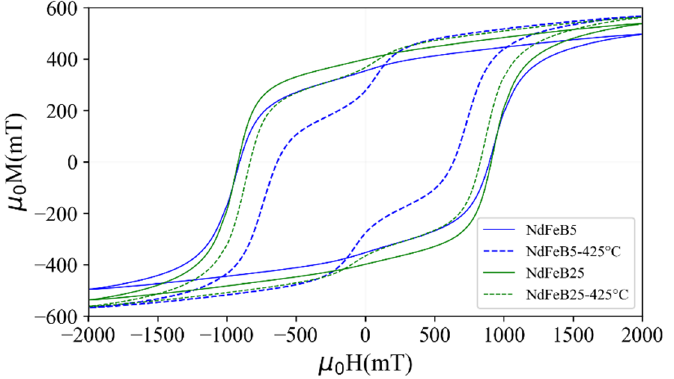
Figure 9. Hysteresis loops of the micromagnets NdFeB5 and NdFeB25 measured before and after annealing at 425 °C at atmospheric conditions for 1 h compared to the as-fabricated hysteresis loops.